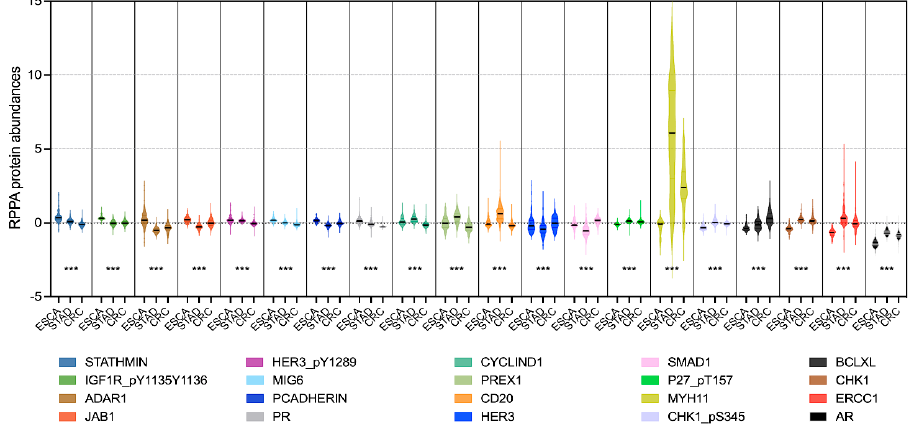
Figure 2. RPPA relative abundances of the 20 selected protein signatures in ESCA, STAD, and CRC samples. Each violin plot shows the minimum, median, and maximum protein abundance in one tumour type. *** p < 0.0001 by ANOVA.